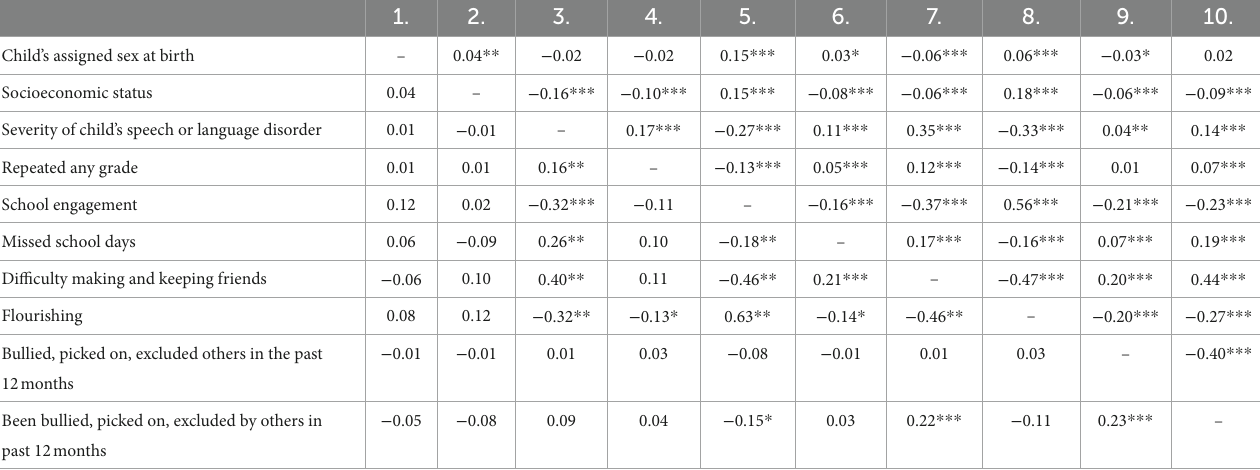
TABLE 4 Correlations among all variables multilinguals (bottom panel) and English monolinguals (top